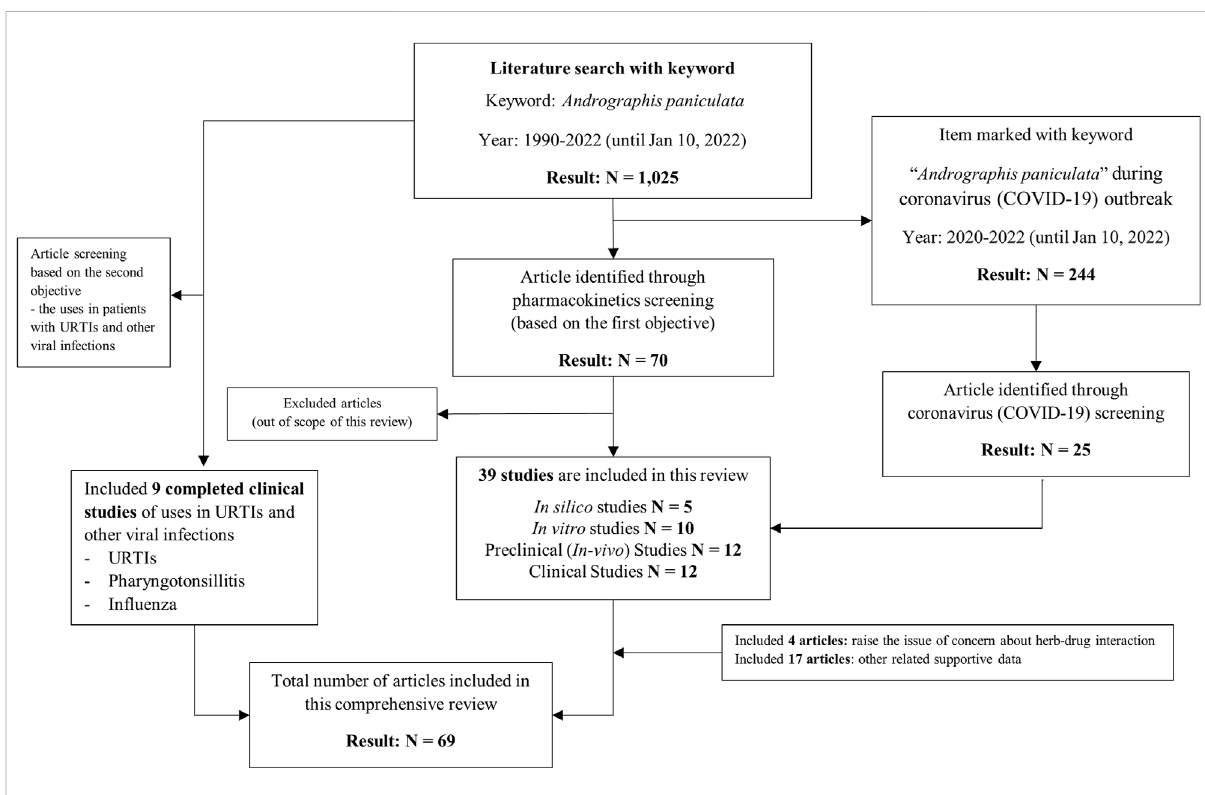
FIGURE 1 Article review of the fl ow